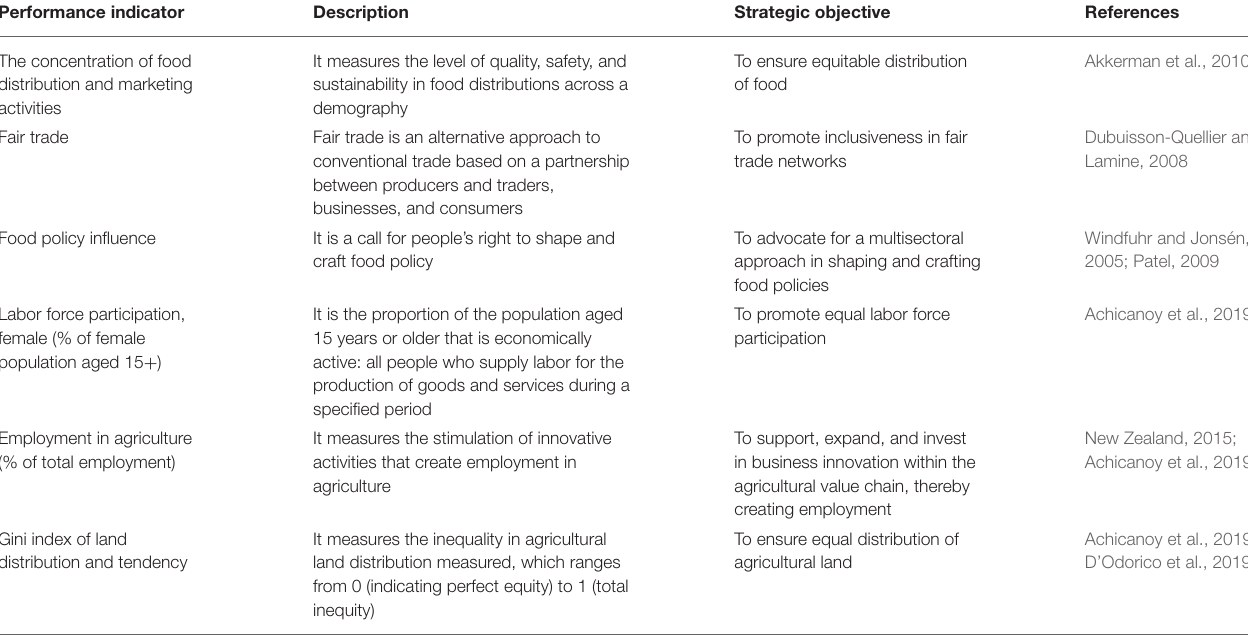
TABLE 4 | Indicators to measure the support to mitigate economic and social inequality and inequity.